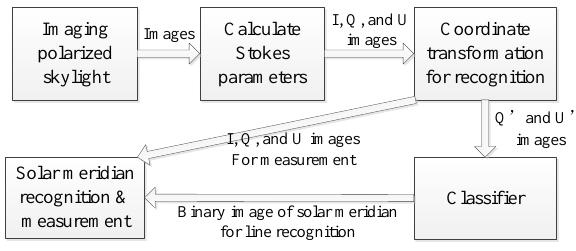
Figure 4. Flowchart of the algorithm of the prototype According to the features of solar meridian above, we designed, implemented, and optimized the polarization imaging and solar meridian recognition algorithm as Figure 4. The algorithm can reduce the operation times of the processor to accelerate the solve rate. The polarization light image can be expressed in the Stokes parameters which can be solve as Equation (2).